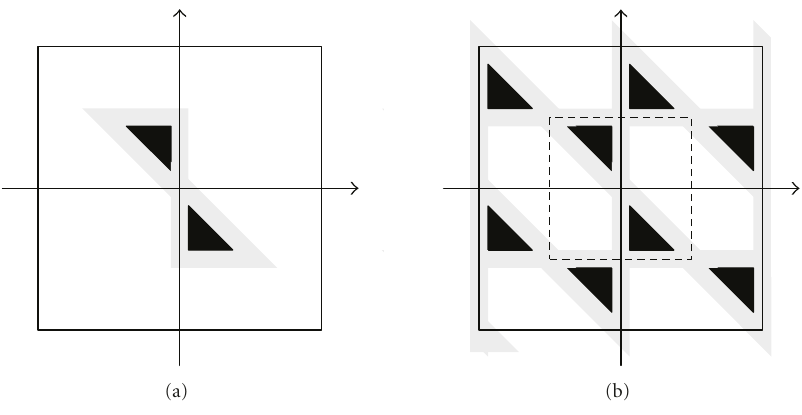
Figure 15: The frequency supports of (a) FH 1 ( ω ) and (b) FH (0) 1 ( D T 2 ω